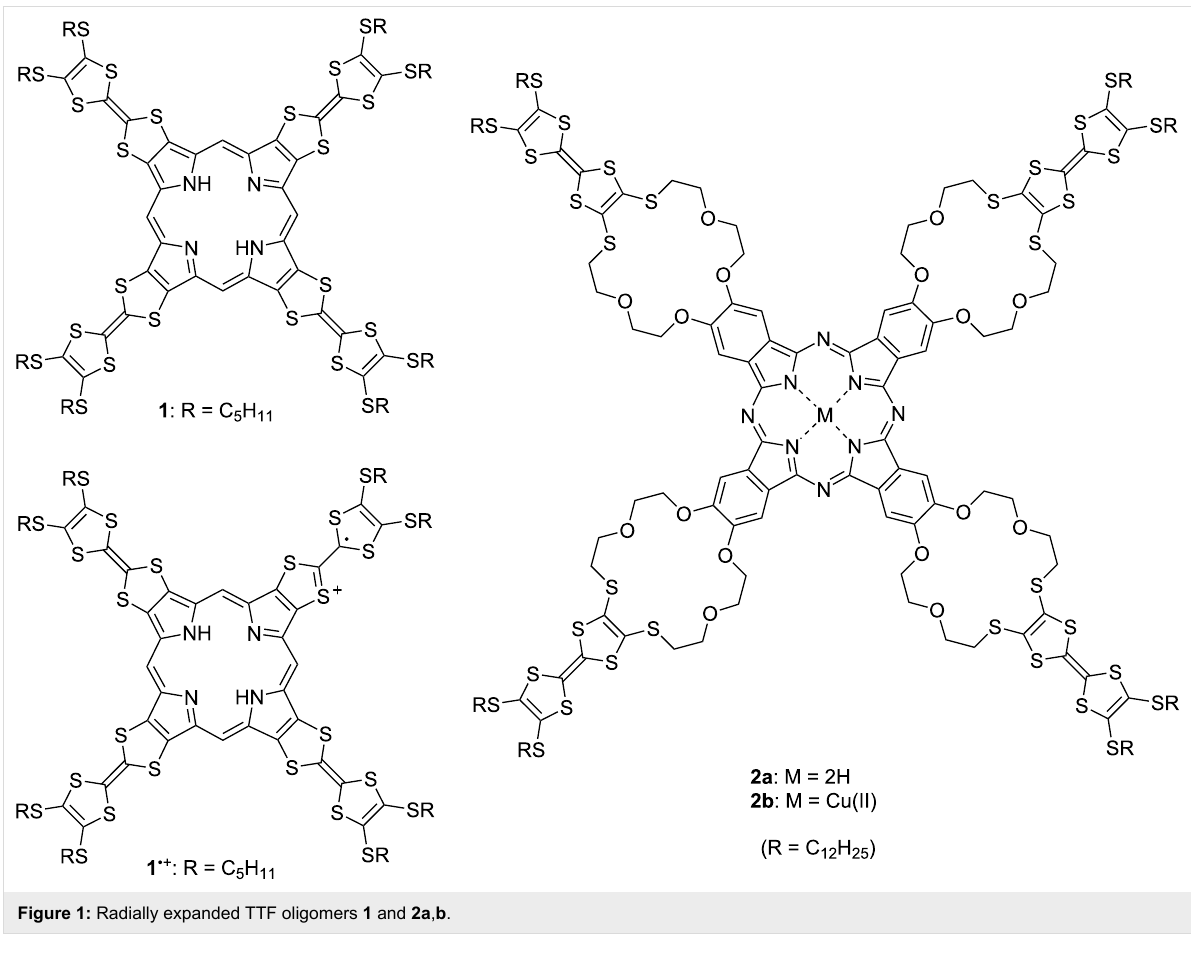
Figure 1: Radially expanded TTF oligomers 1 and 2a , b .